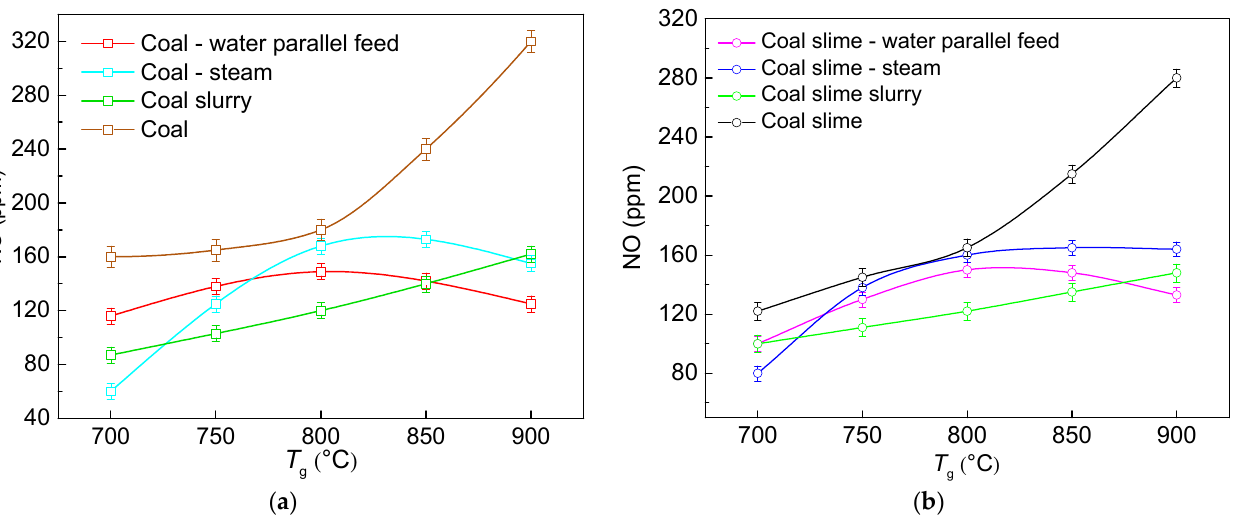
Figure 11. Average concentrations of nitrogen oxide when varying the method of introducing the coal component (coal ( a ) and coal slime ( b )) and water, as well as the temperature in the combustion chamber.